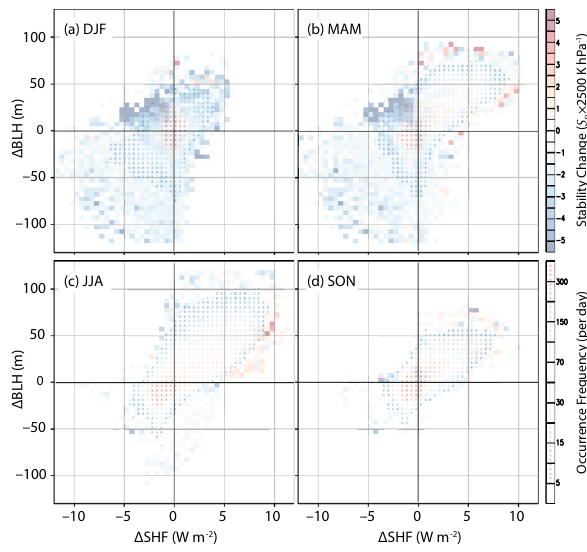
Fig. 10 Seasonal scatter plot of stability change (shade; S p × 2500 K hPa −1 ) at the top of climatological boundary layer over land in SHF- BLH space for the second CSEOF (regional warming) mode: a DJF, b MAM, c JJA, and d SON. The color dots represent the occurrence frequency per